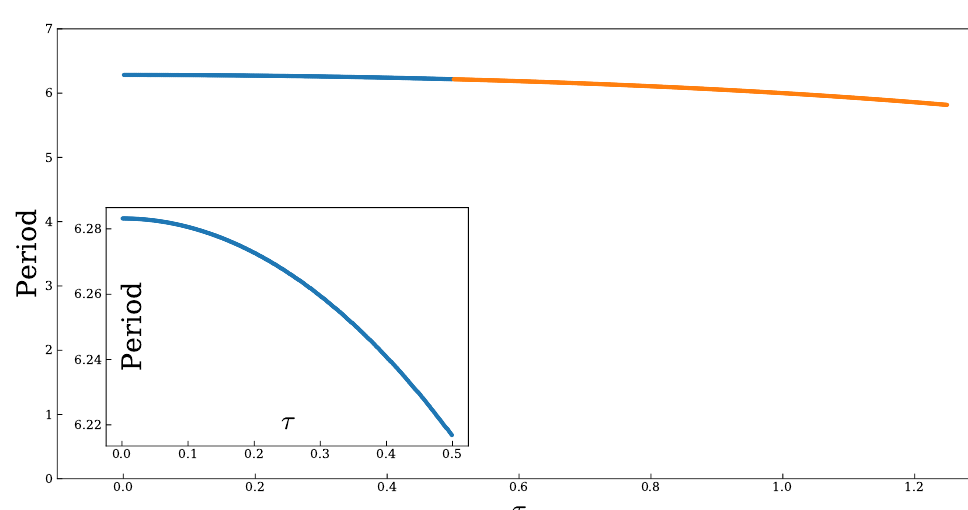
Figure 2. van der Pol oscillator with (cid:101) = 0 (harmonic oscillator). Dependence of the period of the numerical solution with respect to the time step. The inset plot is a close-up of the periods for τ ∈ [ 0.001,0.5 ] .